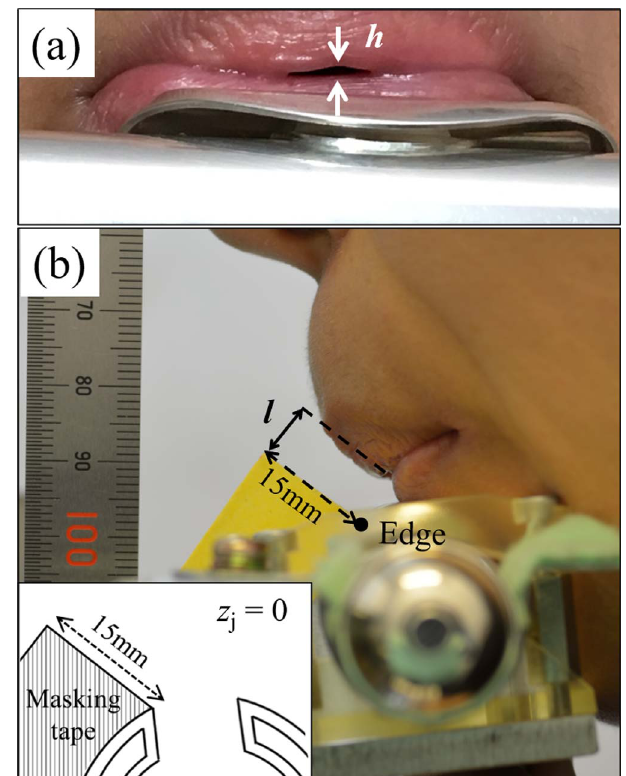
Figure 7. Photographic measurement for cavity exit height (a) and lip-to-edge distance